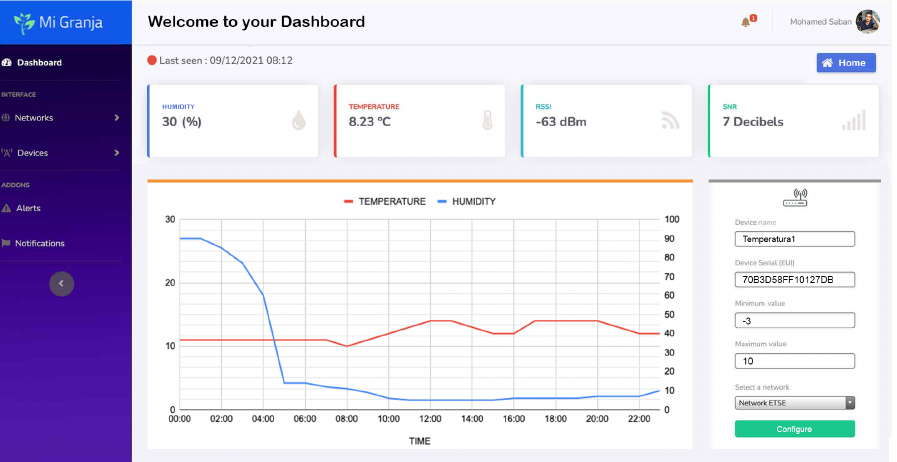
Figure 8. Screenshot from the web application “Mi Granja” showing the dashboard page and relevant data of a temperature